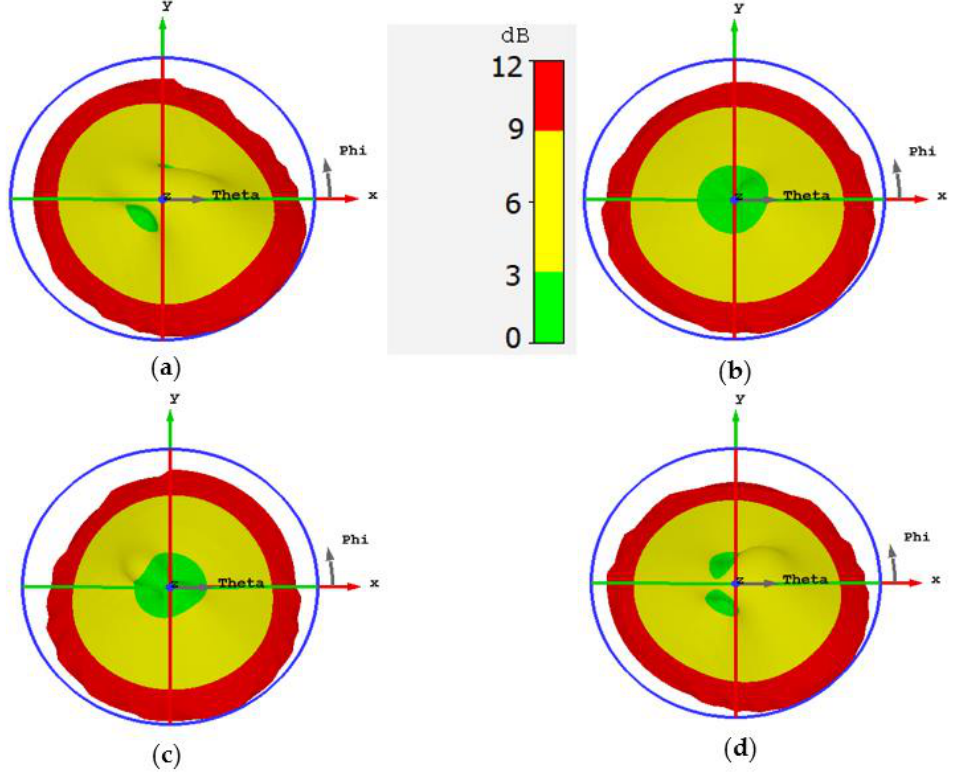
Figure 5. The AR pattern of the proposed antenna at various frequencies. ( a ) 𝑓 = 3.57 𝐺𝐻𝑧 ; ( b ) 𝑓 = 3.6 𝐺𝐻𝑧 ; ( c ) 𝑓 = 3.7 𝐺𝐻𝑧 ; ( d ) 𝑓 = 3.74 𝐺𝐻𝑧 .